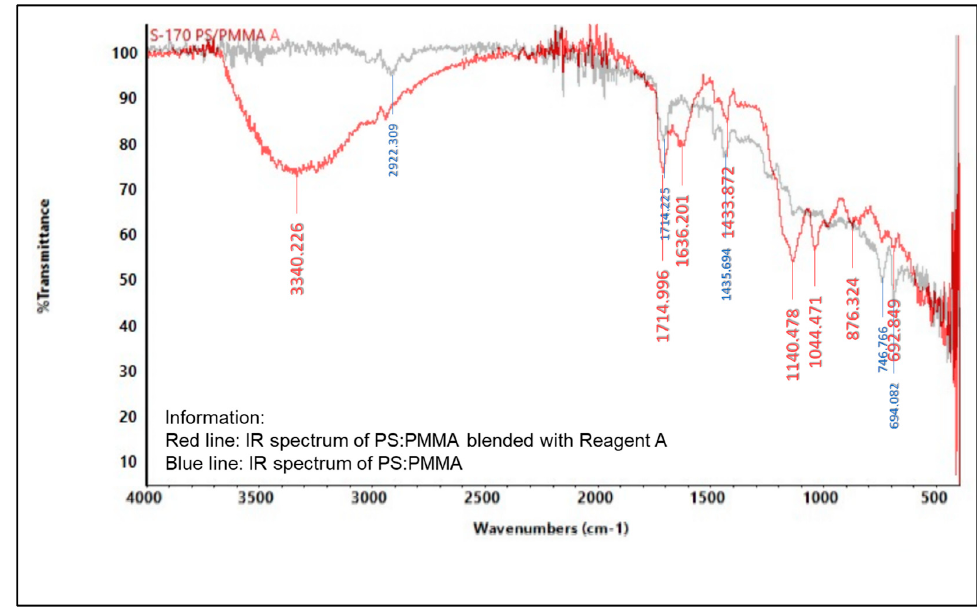
Figure 6. IR spectrum comparison of pure PMMA and blended PMMA with reagent C (10% NaOH).